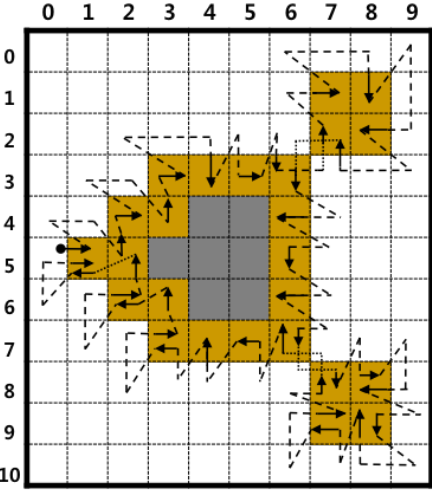
Figure 11. Result of contour tracing using the proposed algorithm.